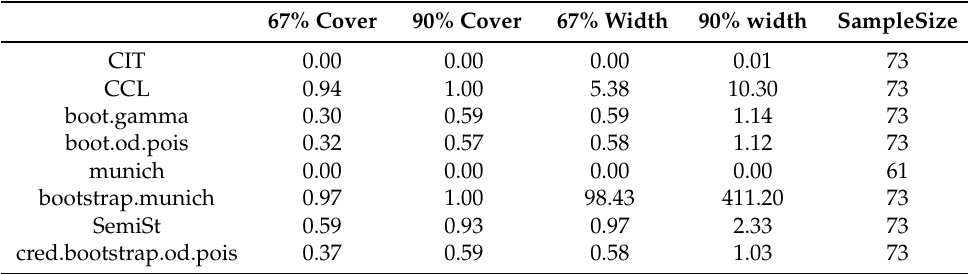
Table 13. Coverage and average width from the private passenger auto liability